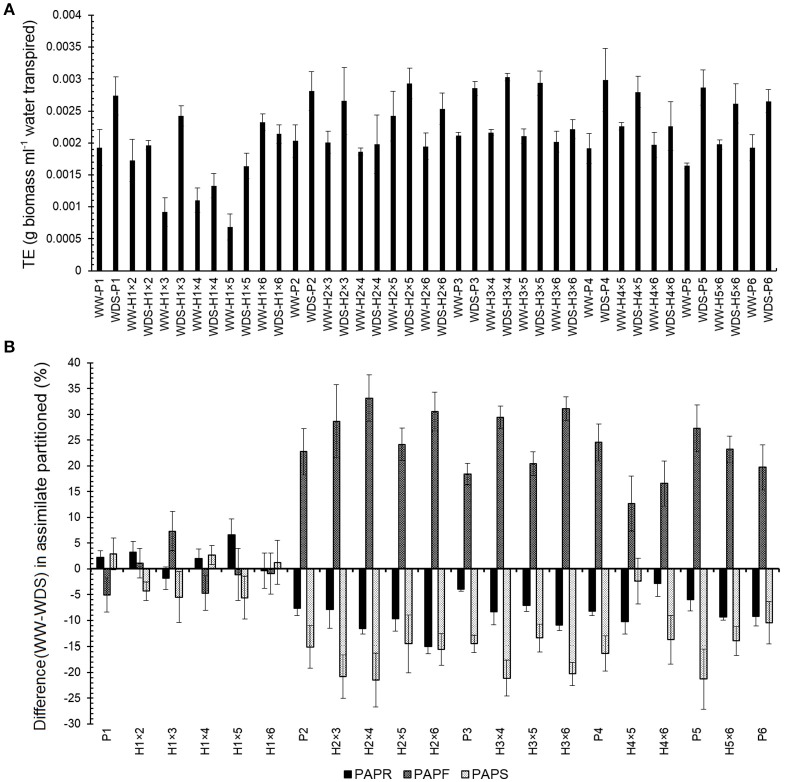
Transpiration efficiency (g biomass ml−1 water transpired) and assimilate partitioning of coriander genotypes. (A) Transpiration efficiency of coriander genotypes under well-watered (WW) and water deficit stressed (WDS). (B) Difference (WW-WDS) in assimilate partitioning of genotypes under well-watered (WW) and water deficit stressed (WDS). PAPR, PAPS, and PAPF are percent assimilate partitioned into root, shoot and fruit, respectively. P1–P6: six parental coriander genotypes; H1×2–H5×6: 15 half-diallel hybrids.